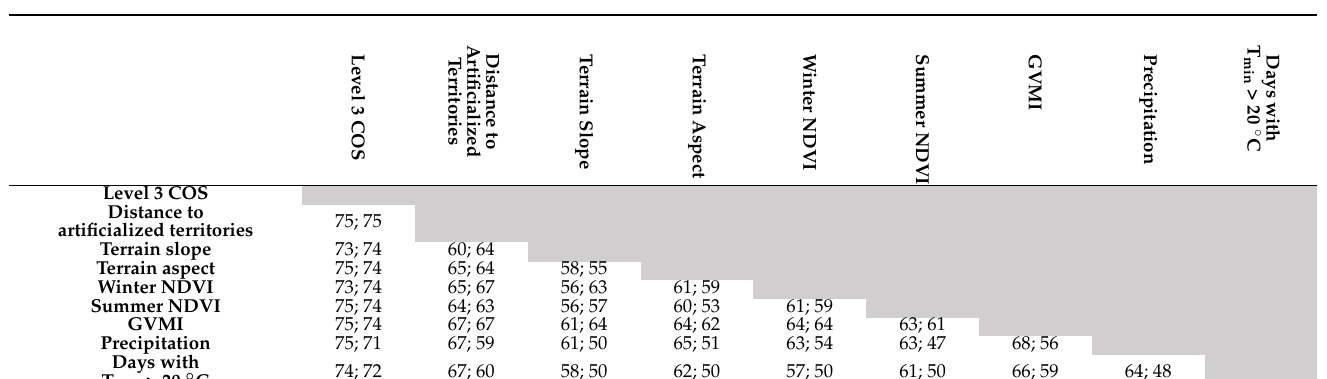
Table 11. Results of the validation of susceptibility models generated with different pairs of environ- mental variables. The value before the semicolon represents the training AUC, while the value after represents the prediction